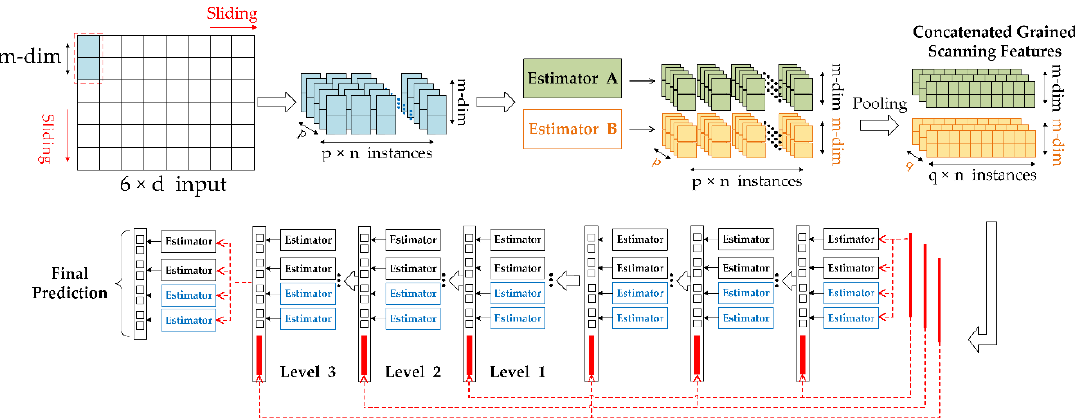
Figure 14. Flow diagram of deep forest.